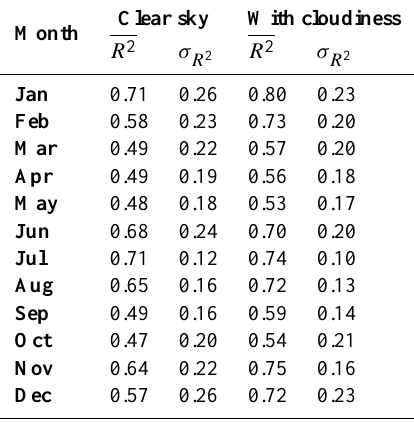
Table 5. The contribution of each predictor in the regression model to the total variability of air surface temperature for the period 1979- 2008. Statistically significant values are in